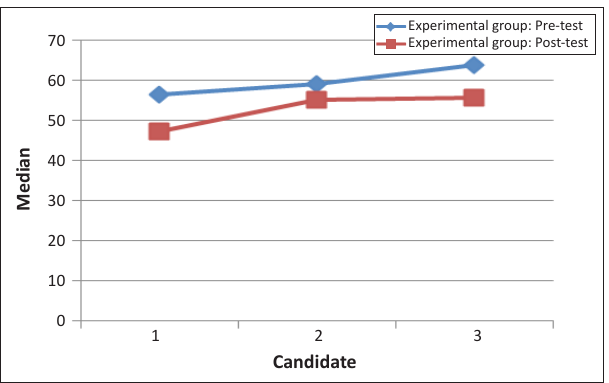
FIGURE 2: The comparison between the pre- and post-test ratings for the group discussion simulation for the experimental group.